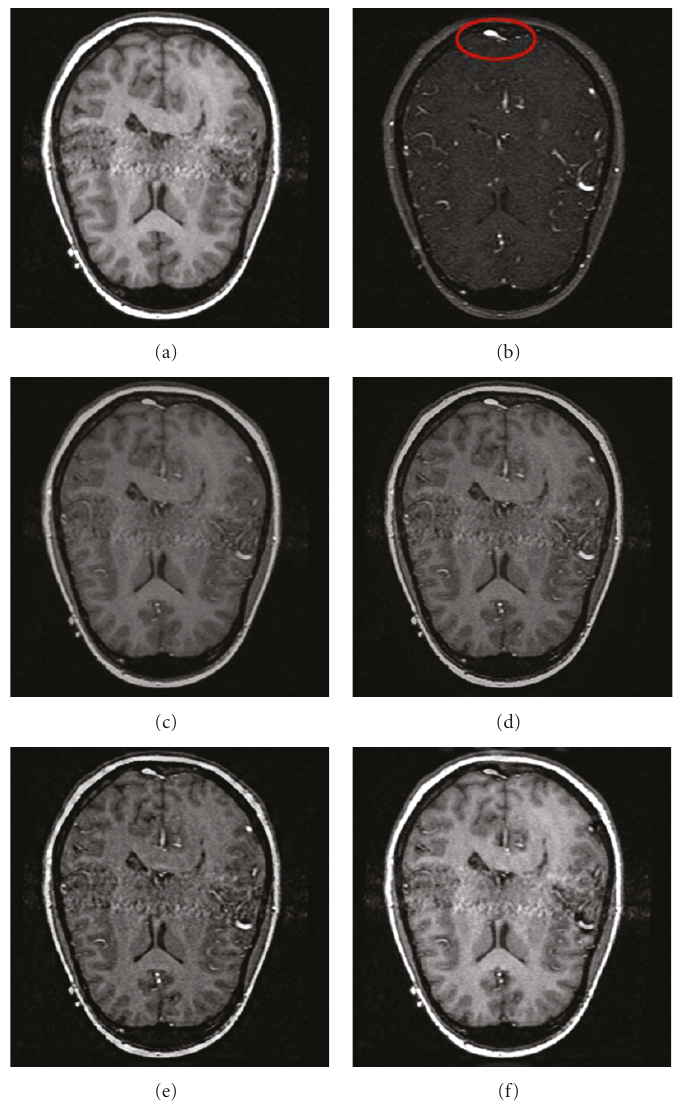
Figure 8: Fusion results of the T1-weighted MR and MRA images with di ff erent methods. (a) Original T1-weighted MR image; (b) original MRA image; (c) fused image by pixel averaging; (d) fused image by gradient pyramid; (e) fused image by DWT; (f) fused image by the proposed